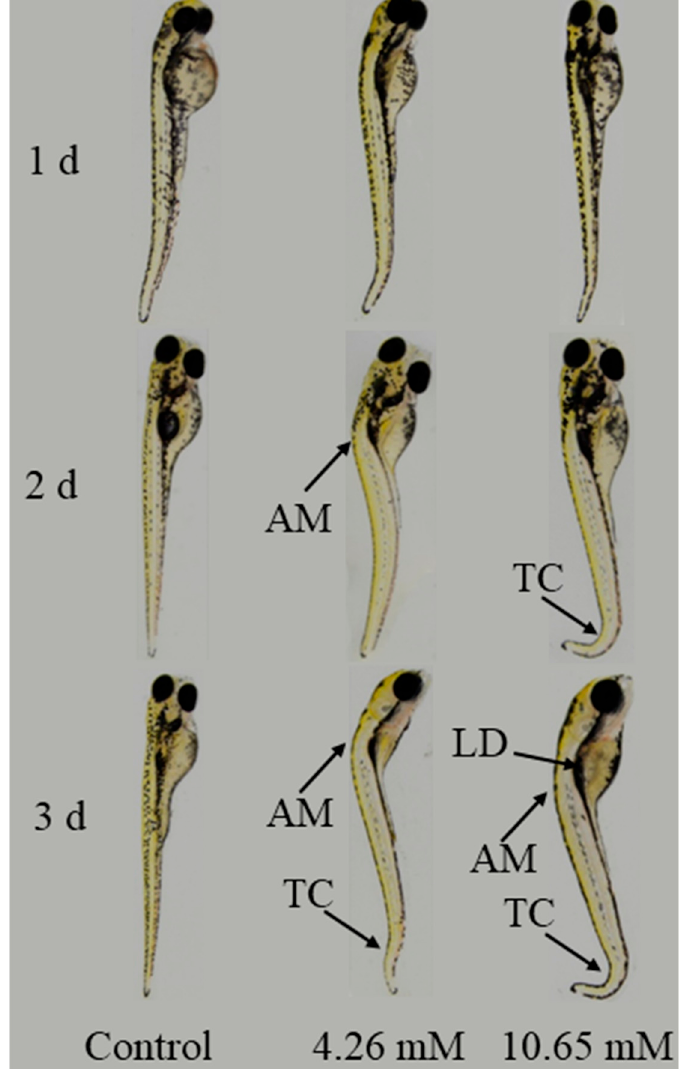
Figure 9. Teratogenic effect of PFLX on a zebrafish larva.